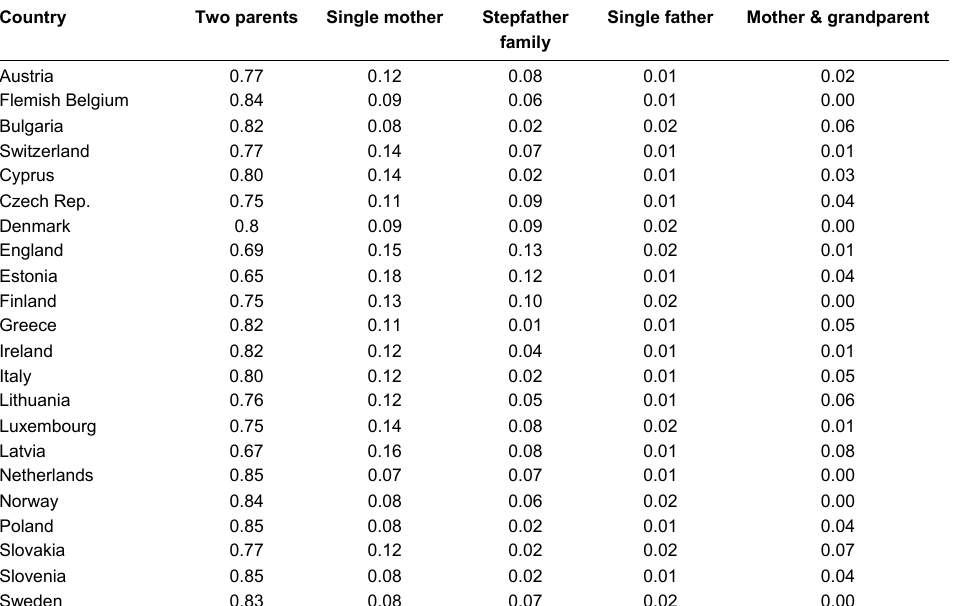
Table A2 : Family forms by country, row percent Country